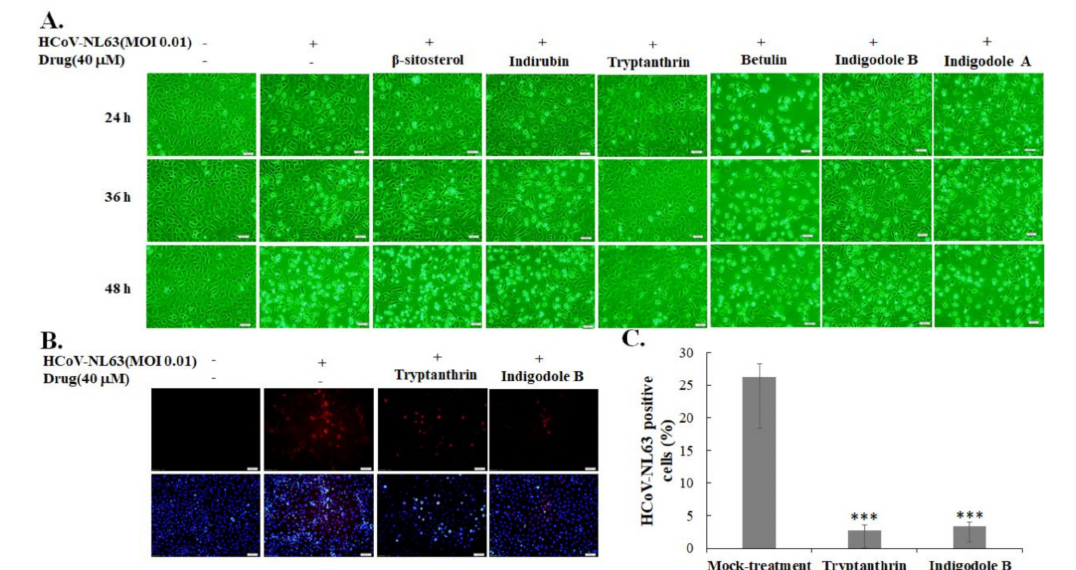
Figure 3. Inhibitory e ff ects of S. cusia extract components on viral cytopathicity and HCoV-NL63 infectivity. LLC-MK2 cells were infected with HCoV-NL63 and immediately treated with 40 µ M of the indicated components for 36 h at 37 ◦ C, photographed for evaluating the relative cytopathic e ff ect (CPE) levels ( A ), and the residual HCoV-NL63 infectivity was determined using immunofluorescence staining with anti-HCoV-NL63 antibodies ( B , top) and DAPI ( B , bottom). The ratio of HCoV-NL63-positive cells was calculated as the percentage of positive cells to total cells ( C ). + , add; − , not add; ***, p value < 0.001 compared with mock-treatment group. Scale bar, 100 µ